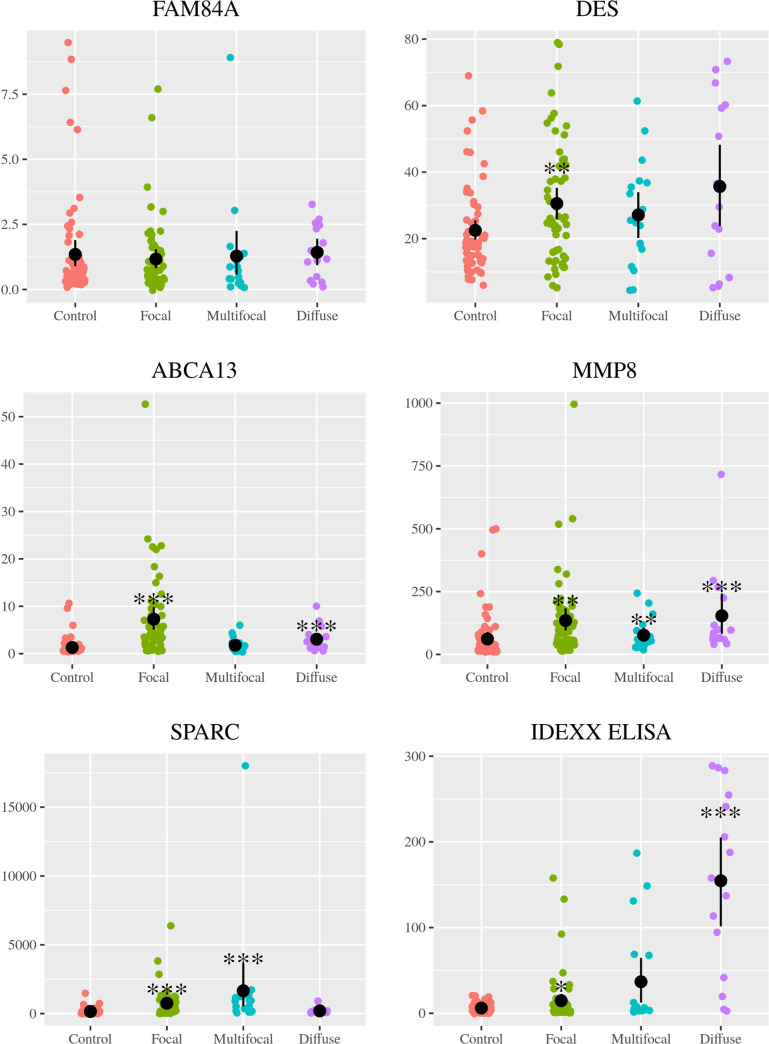
Biomarker expression levels in serum of Holstein Friesian cattle showing different types of histological lesions consistent with PTB in their intestinal tissues (focal (n = 55), multifocal (n = 18), and diffuse (n = 15)) and in non-infected control animals (n = 67).The number of animals with focal, multifocal, diffuse or with any type of lesions represented in the plot for the ABCA13-based ELISA was 53, 16, 14 and 83, respectively. Biomarkers were detected and quantified in bovine serum by specific ELISAs supplied by MyBioSource, San Diego, CA, USA. FAM84A, bovine family with sequence similarity 84 member A; DES, bovine desmin; ABCA13, bovine ATP binding cassette subfamily A member 13; MMP8, bovine matrix metallopeptidase 8; SPARC, bovine secreted protein acidic and cysteine rich; IDEXX ELISA. The data are represented as scatter plots with each dot representing a single animal. The mean of each histopathological group is represented by a gross black point and the standard deviation by a vertical line. The asterisks indicate if the differences between each histopathological group and the control are or not significant (*, p<0.05; **, p<0.01; ***, p<0.001).